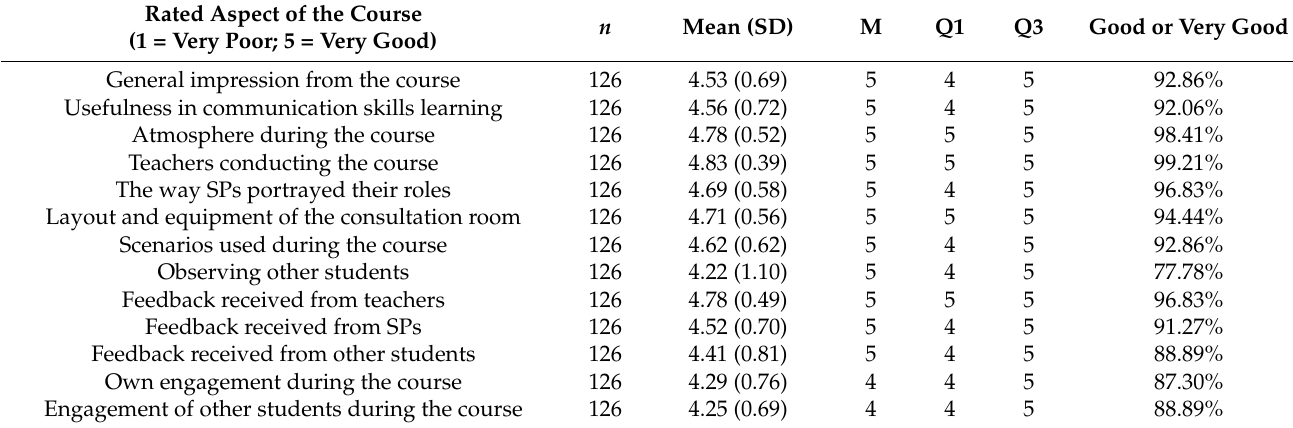
Figure 3. Differences in ratings of doctors and observers. Table 3. Students’ ratings of particular aspects of the